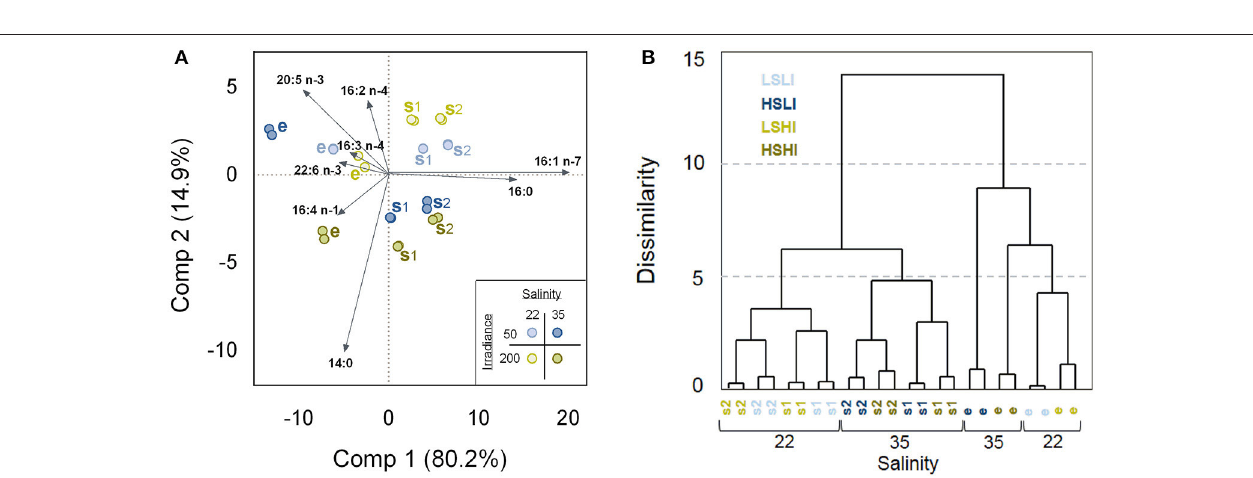
FIGURE 5 | Similarities and differences in relative fatty acids (FA) composition (% of total fatty acids [TFA]) of Attheya septentrionalis cultures at 12 treatments during the factorial-design batch experiment (each with two biological replicates). Treatments were altering combinations of the three factors salinity (22 and 35), irradiance (50 and 200 µ mol photons m − 2 s − 1 ) and growth phase (e, s1, s2). (A) Principal component analysis (PCA). Twenty-four objects representing the 12 treatment groups, and eight variables, representing the FAs with highest impact on the distributions. Values are average of three measurement replicates. e, exponential phase; s1, first stationary phase (Day 3); s2, second stationary phase (Day 5). (B) Euclidean Dendrogram showing dissimilarities between the treatment groups. LSLI, low salinity and low irradiance; HSLI, high salinity and low irradiance; LSHI, low salinity and high irradiance; HSHI, high salinity and high